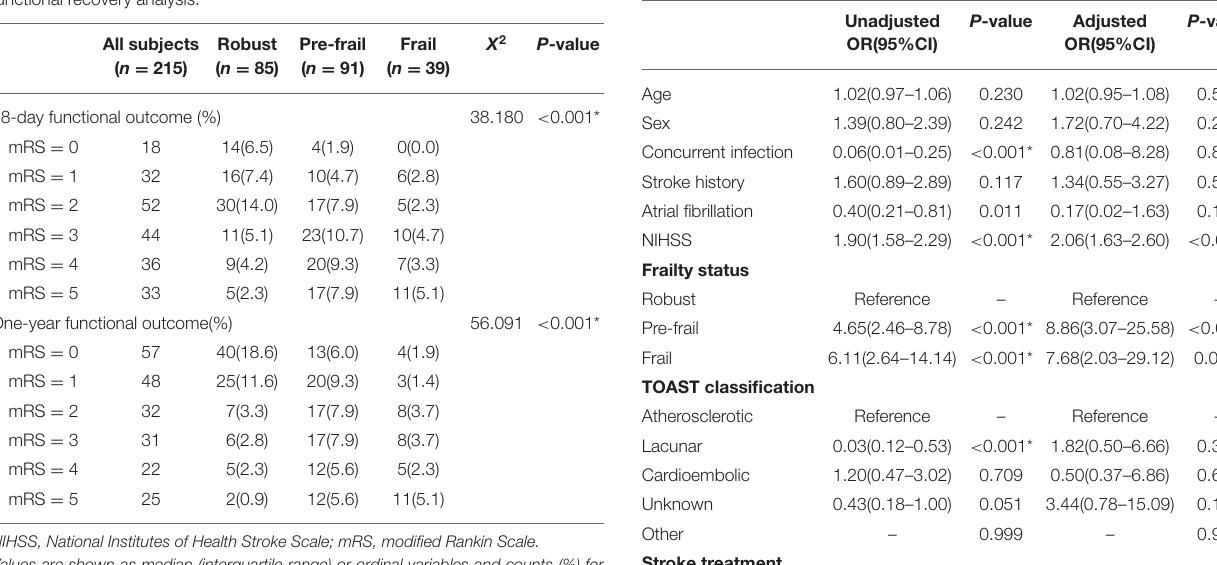
TABLE 5 | The modified Rankin Scale (mRS) for each group of frailty status for a 28-day functional outcome and a 1-year follow-up functional outcome for functional recovery analysis.